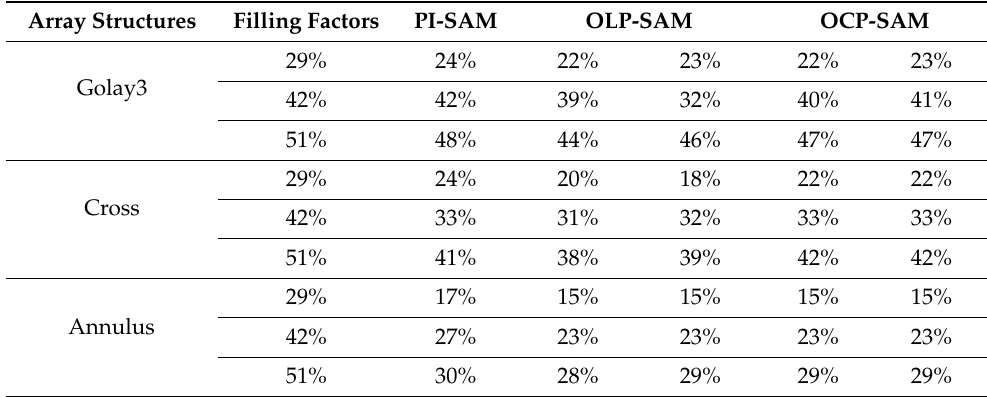
Table 3. The focusing efficiency of different